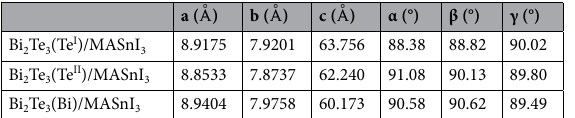
Table 1. Lattice parameters of various interfaces after structural optimization.